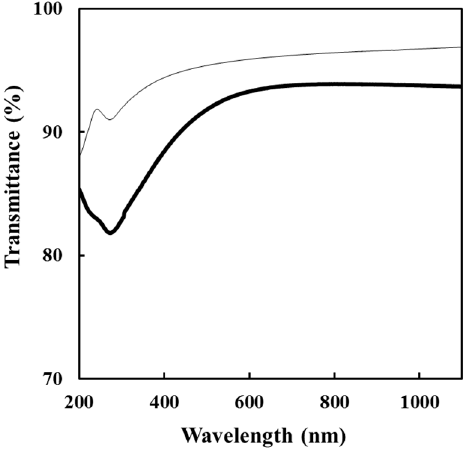
Figure 4. Transmittance spectra of F COMP (bold line) and F CNT (thin line).